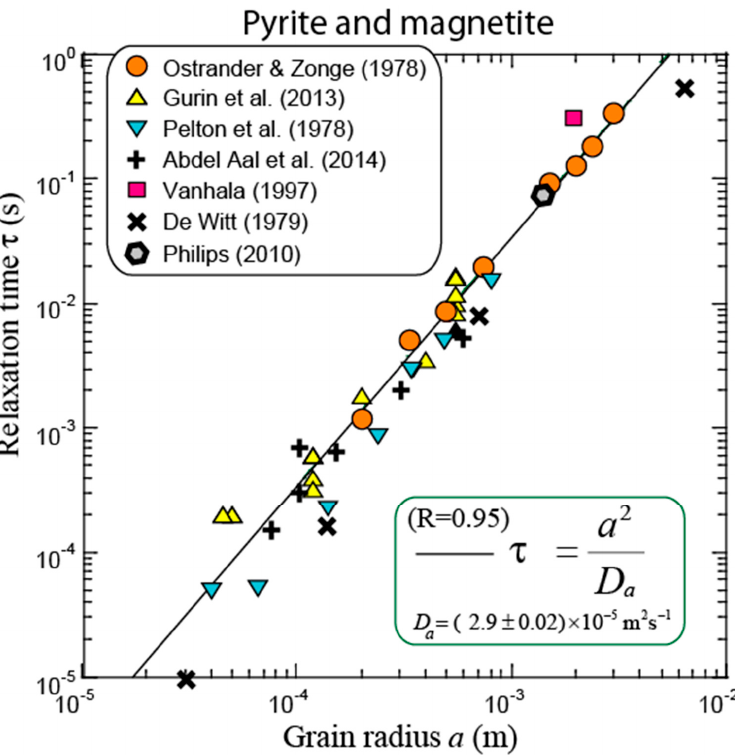
Figure 14. Time constant ( τ 0 = 1/(2 π f peak )) for the complex conductivity model versus the radius of the metallic particles. The quantity ( f peak ) denotes the critical frequency that corresponds to the maximum of the phase. The diffusion coefficient ( D ) is an apparent diffusion coefficient for the charge carriers responsible for the polarization process. Experimental data: Pelton et al. (1978) [11] (pyrite); Gurin et al. (2013) [70] (a mixture of pyrrhotite (v.30%), pyrite (v.30%), magnetite (v.30%), and chalcopyrite (v.10%)); Abdel Aal et al. (2014) [72] (pyrite and magnetite); Ostrander and Zonge [90] (1978) (pyrite); Vanhala (1997) [91] (pyrite from his Figure 16); De Witt (1979) [71] (pyrite grains); Phillips (2010) [82] (pyrite, sample K01, sericite quartz, 10% vol. pyrite). The smallest relaxation times are more scattered, possibly because of the influence of Maxwell–Wagner polarization at high frequencies. Background conductivity: σ b ~10 − 2 –10 − 3 S m − 1 . Modified from Revil et al. (2015c)